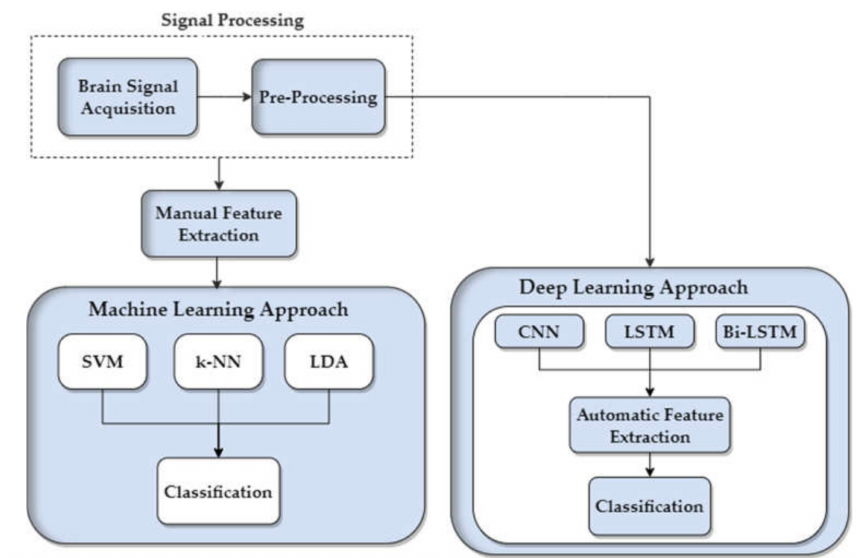
Figure 2. Time-series functional near-infrared spectroscopy (fNIRS) signal classification for walking and rest tasks using conventional machine-learning (ML) and DL algorithms. Signal processing and feature engineering followed by classification using ML and DL